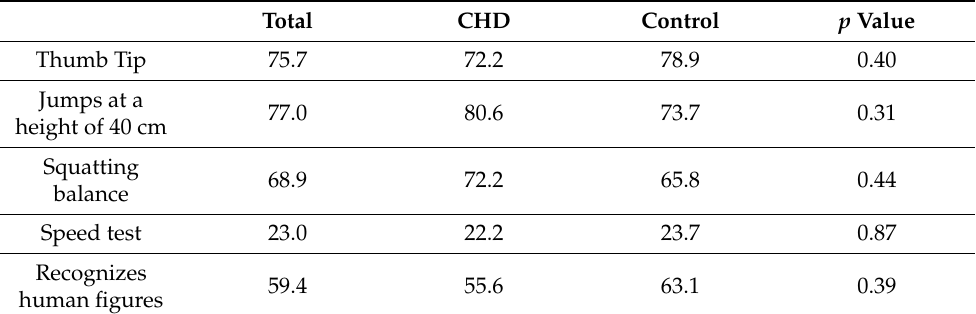
Table 2. Percentage of children with satisfactory performance in each of the motor tests.